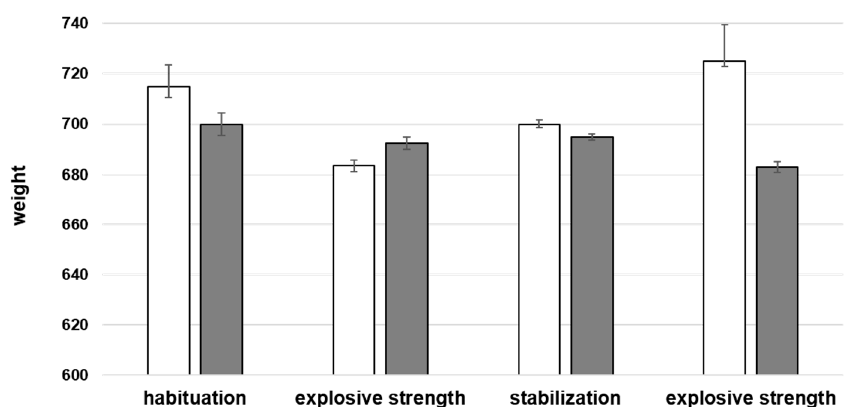
Figure 3. Trend of Northern goshawk’s weight during the high-tech training. Median value ± standard error of Accipiter gentilis ’s weight gained during the entire training. White bins: 1st week; grey bins: 2nd week. Wilcoxon test for non-parametric data, results are given as a range (always W > 0, p > 0.2).